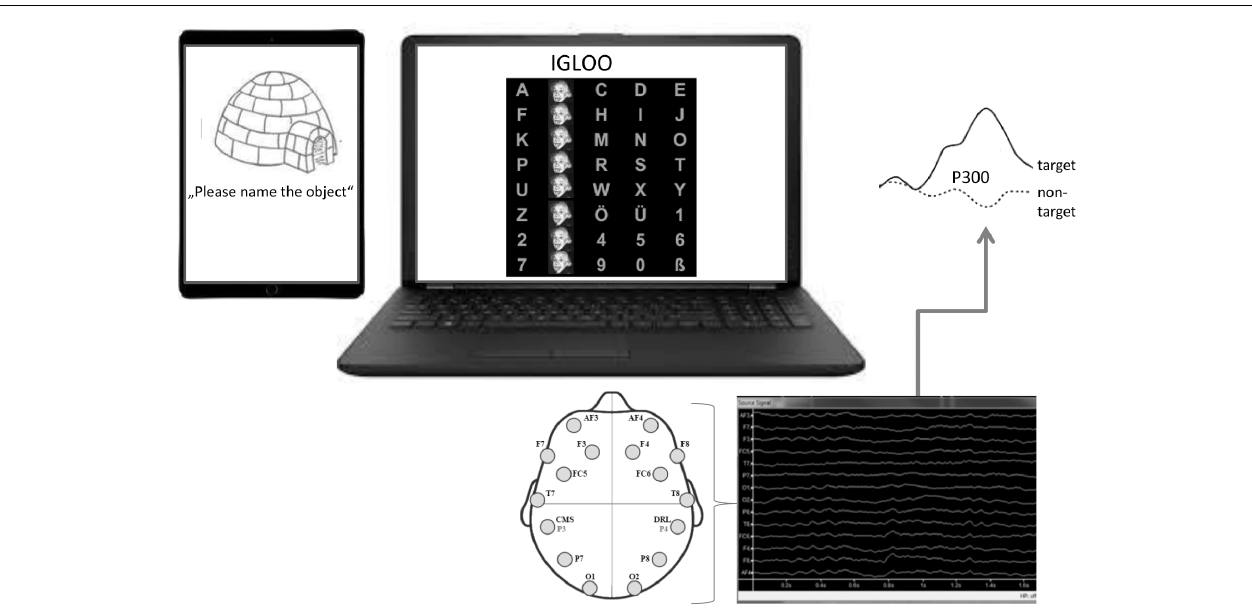
FIGURE 1 | BMI set-up. Left: Positions of the 14 electrodes of the Emotiv Epoc headset according to the 10–20 system. Middle: 8 × 5 speller matrix for the P300 speller. Rows and columns of symbols were disguised for 62.5 ms by faces (Albert Einstein) with a 200 ms interstimulus interval signal.